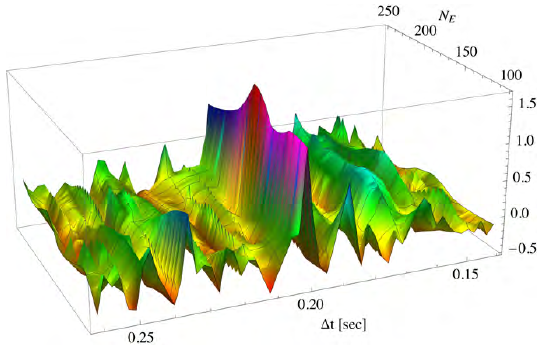
Figure 27. Correlation vs. echo time delay ∆ t echo vs. N E for GW170104 using method II [21]. Here N E FIG. 11. Correlation vs. time delay for different N E for GW170104 with method II. is the number of frequency steps between procedure for the same time delay range on some number of trials, based on various time- translated parts of the LIGO data. The black curve shows the probability of finding a highest peak of equal or greater height compared to the midpoint bin value. The red dot denotes the signalpeak, andtheresulting p -valueestimatemaybelimitedbythenumberoftrials. Methods I and III only require a short range of data and so with the full one hour of LIGO data we can generate a sufficient number of independent background trials. Method II uses larger echo numbers and needs a longer range of data. To generate a sufficient number background trials in this case we employ random time shifts between pairs of segments from the two detectors. (For GW170608 we use only 512 s of data, which is all the noise-subtracted data available.) A signal peak tends to persist over various changes of the window parameters more so than a noise peak. Figure 11 shows an example of the persistence of the signal peak as a function of N E for GW170104, which makes clear that an averaging of the correlations over N E will improve the signal. The window parameters used are summarized in Table I along with the best-fit value of t d , the p -value and the frequency bandpass for each analysis. The bandpass turns out to be around the most sensitive region for the detectors. For smaller (larger) mass events, the upper (lower) end starts to sample higher noise levels, but it is still away from where the noise gets significantly larger. As we have mentioned earlier, it is convenient to express the bandpass as a dimensionless range, ( f min , f max ) t d . In method II the optimal bandpass stays quite stable over the four events as it varies between ( 12,58 ) to ( 16,62 ) , while for the other two methods it shifts higher. Table I also shows several instances where leaving out some number of the early echoes can positively contribute to the strength of the signal. Valuesof t d aredeterminedfromtwodifferentmethodsforGW151226andGW170814, and